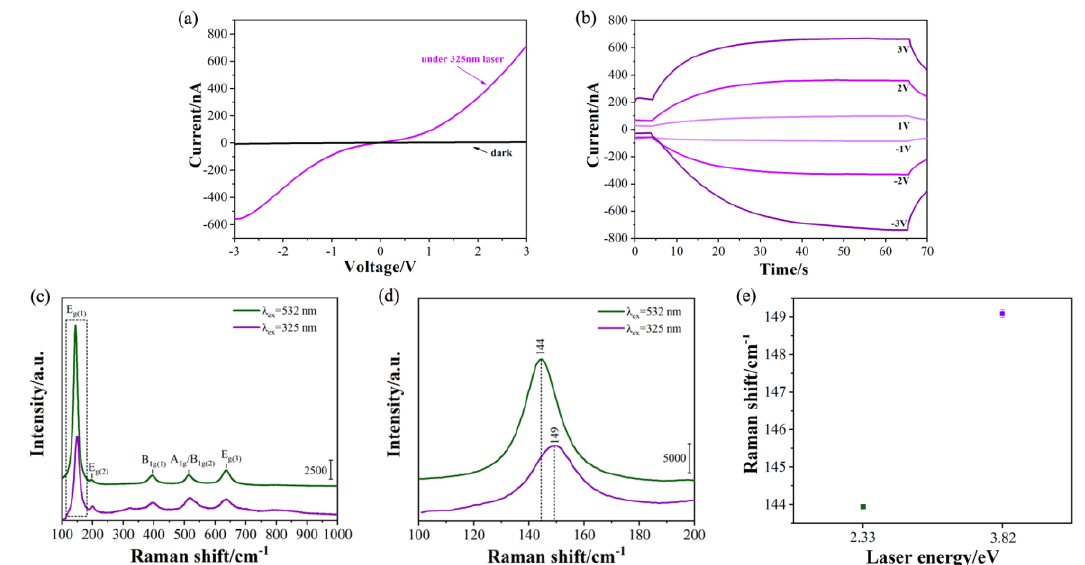
Figure 7. ( a ) I - V curve and ( b ) fast-response measurements of a TNA-based PD with a tube length of 7 µ m under 325 nm excitation; ( c ) in situ Raman spectra of TNA-based PD collected at excitation wavelengths of 532 nm and 325 nm; ( d ) enlarged Raman spectrum in the 110–200 cm − 1 region; ( e ) The reproducibility of Raman measurements.